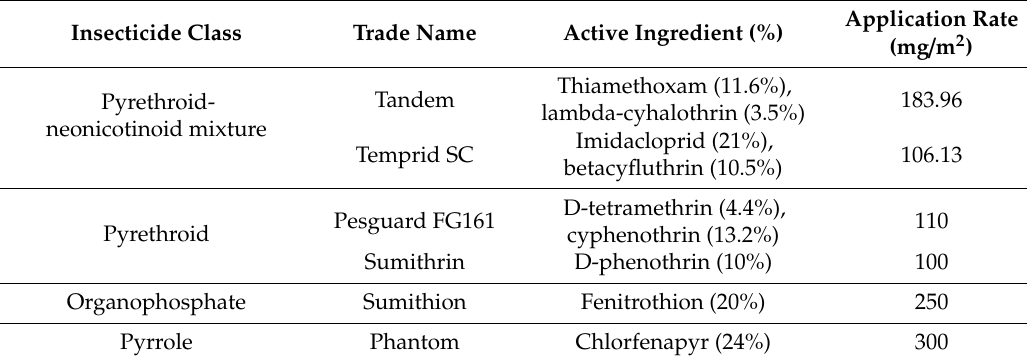
Table 2. Insecticide products used in this